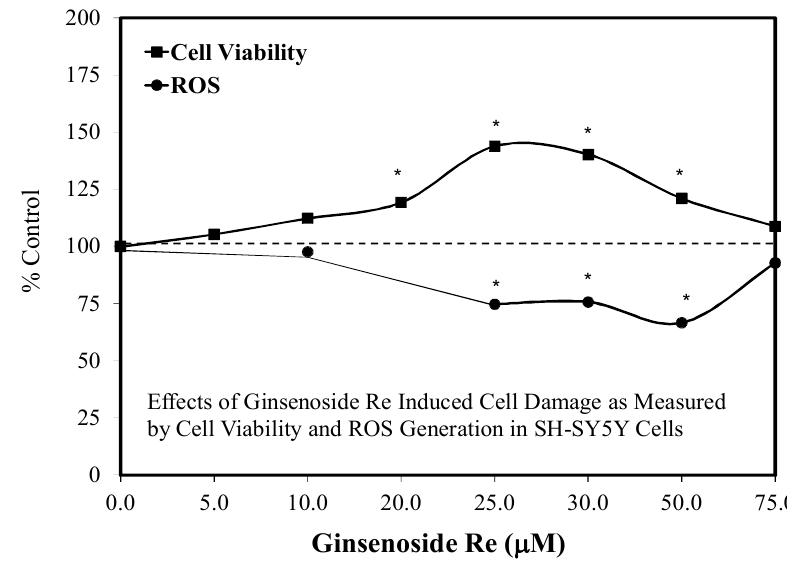
Figure 39. Effects of ginsenoside Re-induced cell damage as measured by cell viability and ROS generation in SH-SY5Y cells (source: [121]). Each * represent statistical significance for a data point.